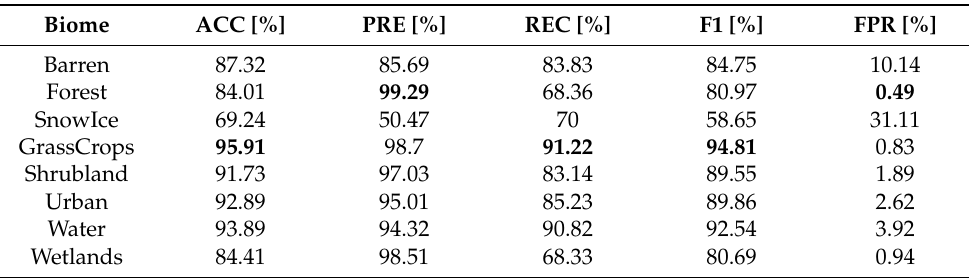
Table 5. Results of cloud coverage classification for best-performed 4-bit width models per biome employing full L8-D dataset.